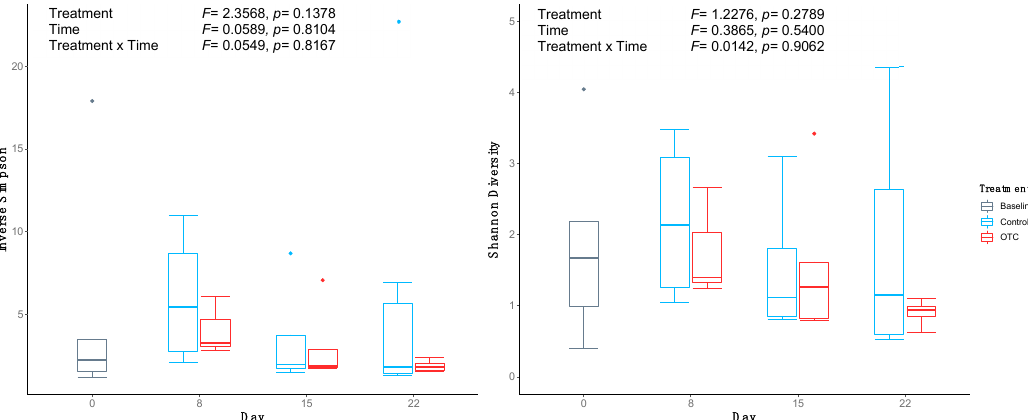
Figure 2. Alpha diversity measures of distal gut microbiome communities in control or oxytetracycline (OTC)-treated Nile tilapia before and after antibiotic treatment. Error bars indicate the 95% confidence interval; top, middle, and bottom of each box represent the 75th, 50th, and 25th percentiles, respectively. Circles indicate outliers from the dataset.